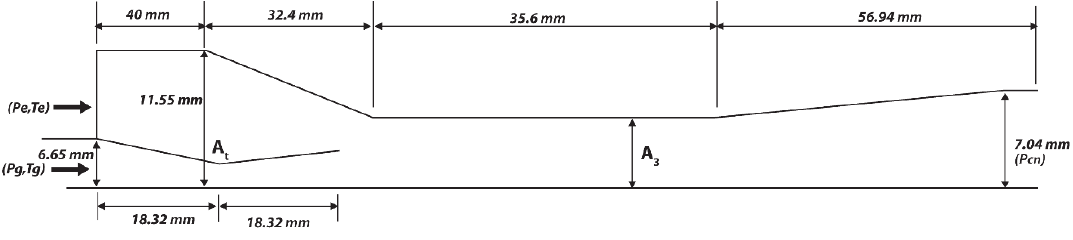
Figure 8. General geometrical configuration .